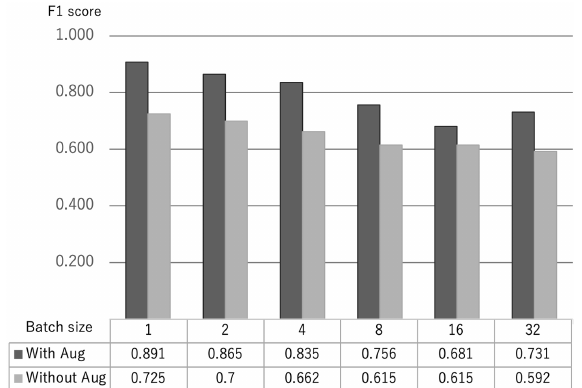
Figure 3. Weighted average of F1-scores per batch size with and without augmentation for learning rate 2 × 10 − 5